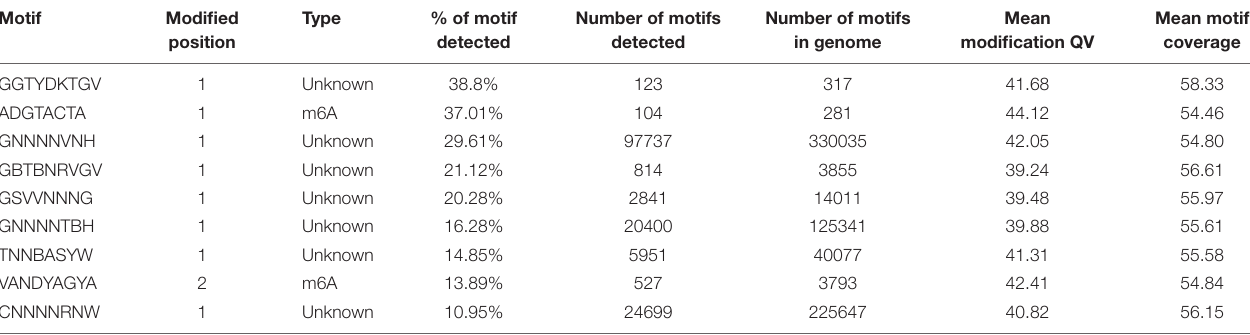
TABLE 3 | Methylated motifs detected in the strain F. tularensis subsp. holarctica strain 12T0050_FLI.